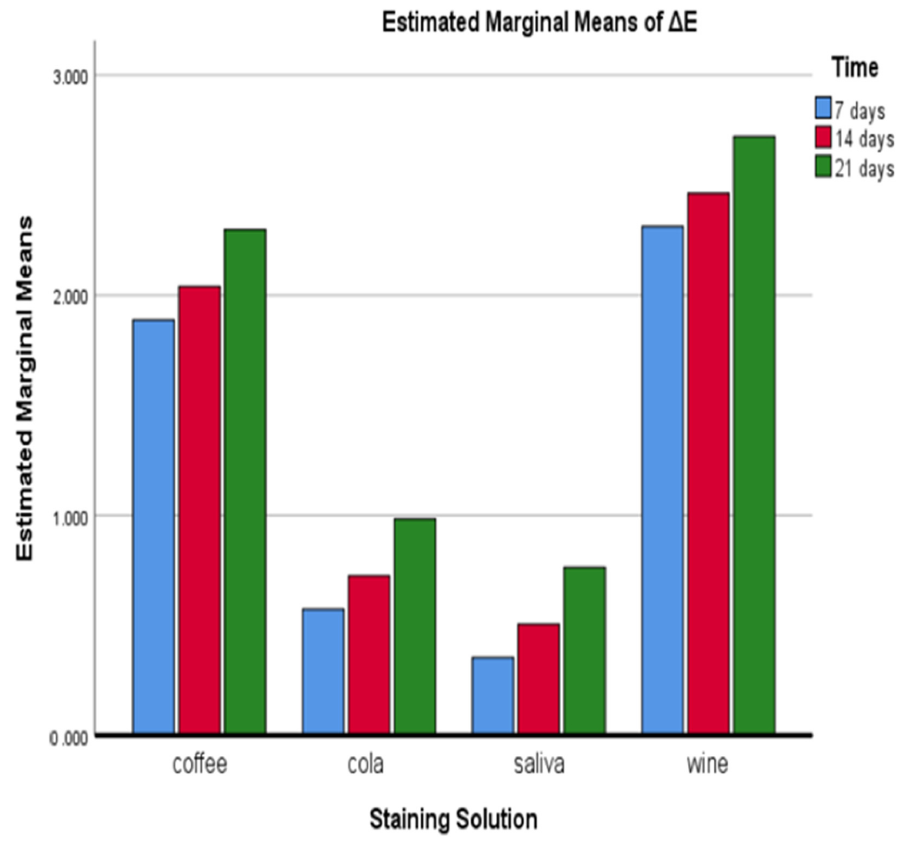
Figure 3. Interactive plot for mean colour difference—interaction between estimated marginal means of ∆ E and type of staining solution.